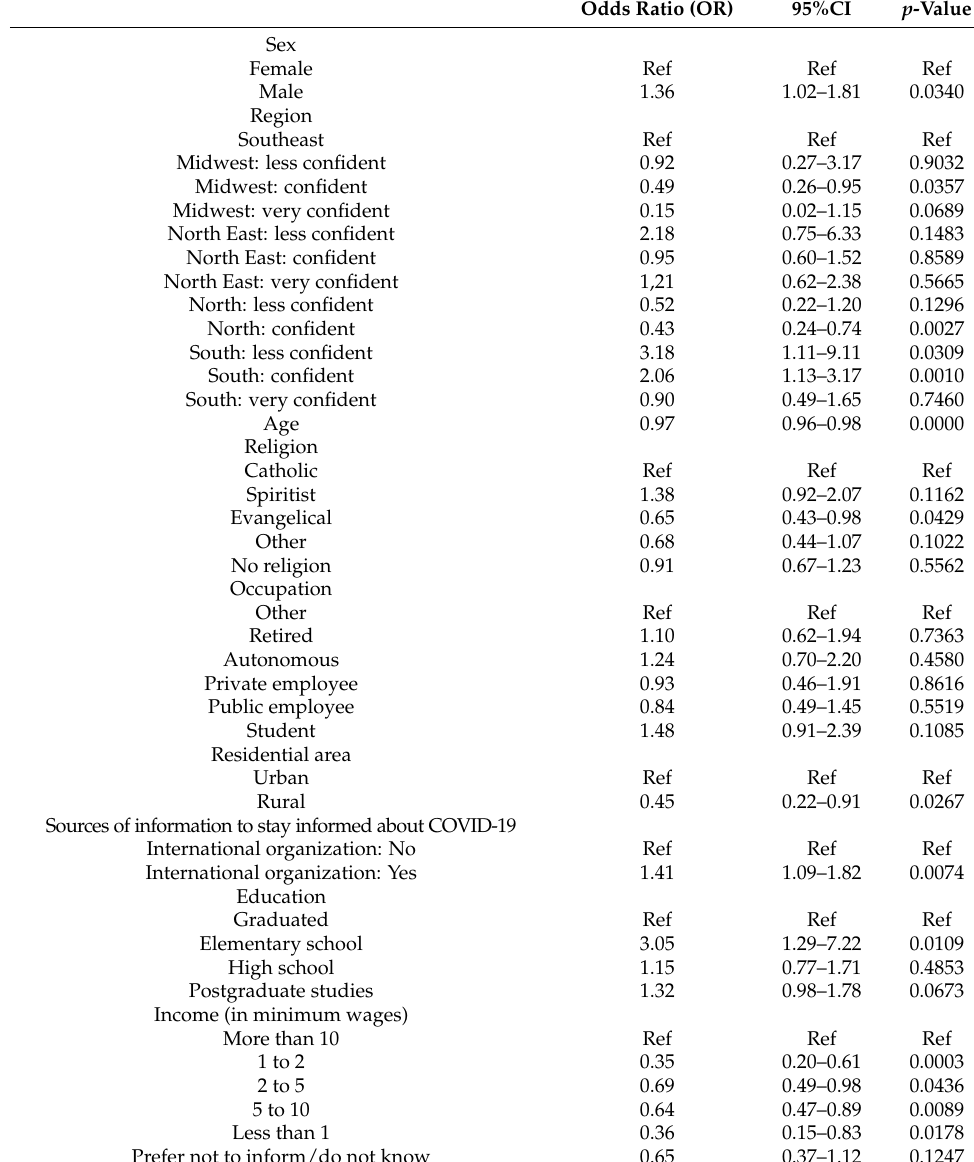
Table 4. Final models regarding the trust level toward hospital services ( n =